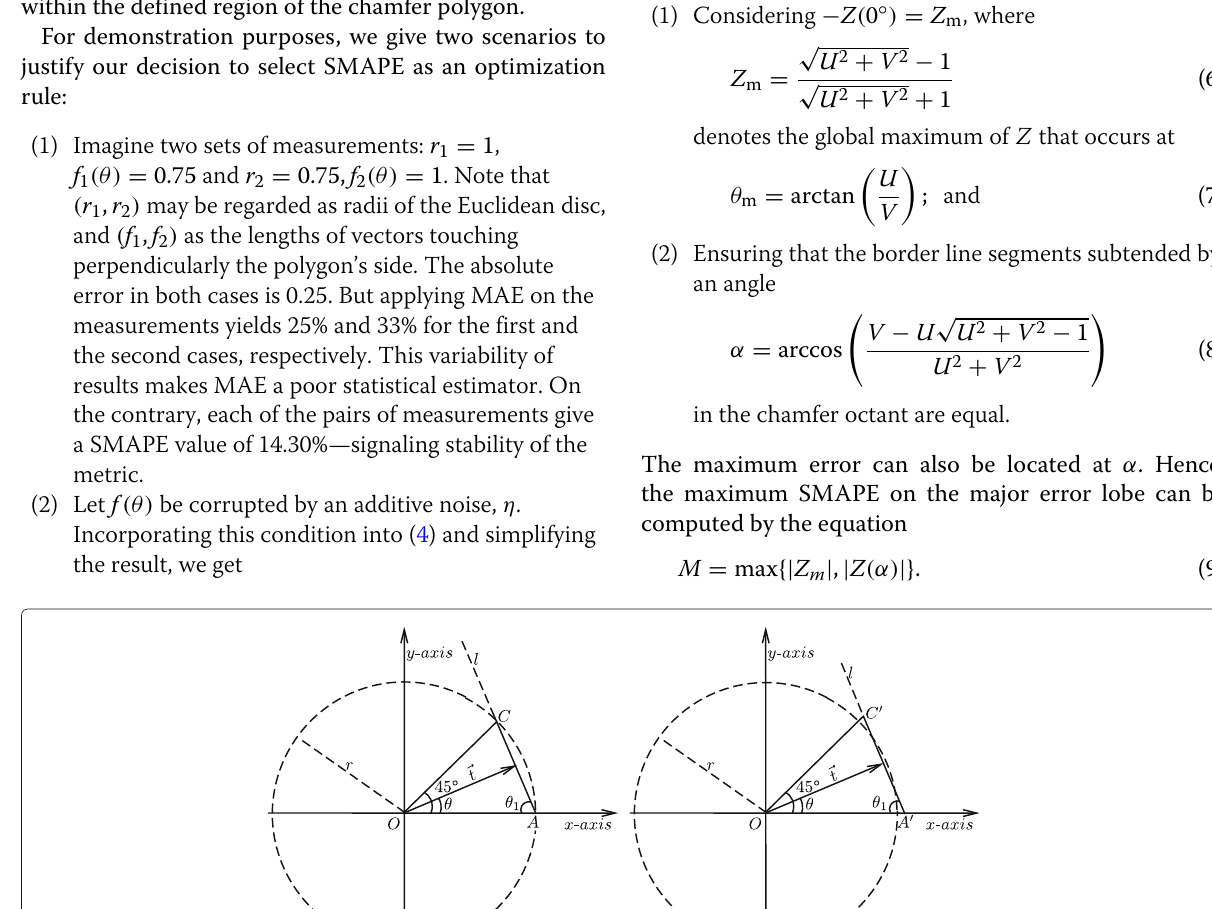
(cid:6) (cid:7) r √ , r √ . b Optimized weights, A (cid:6) = 2 2